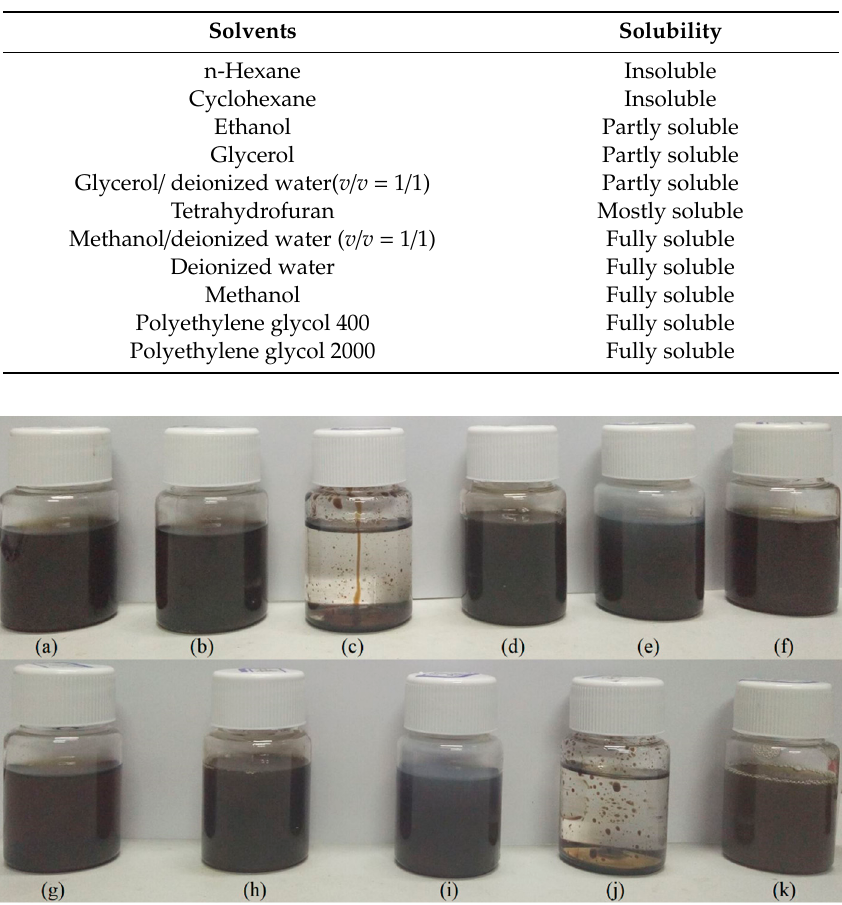
Table 2. Solubility of liquefied products in conventional solvents.